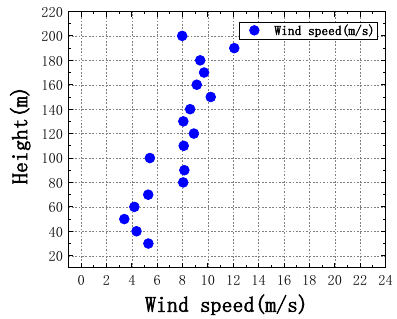
Figure 8. Schematic diagram of cross-bridge windward profile (α = 0.33).